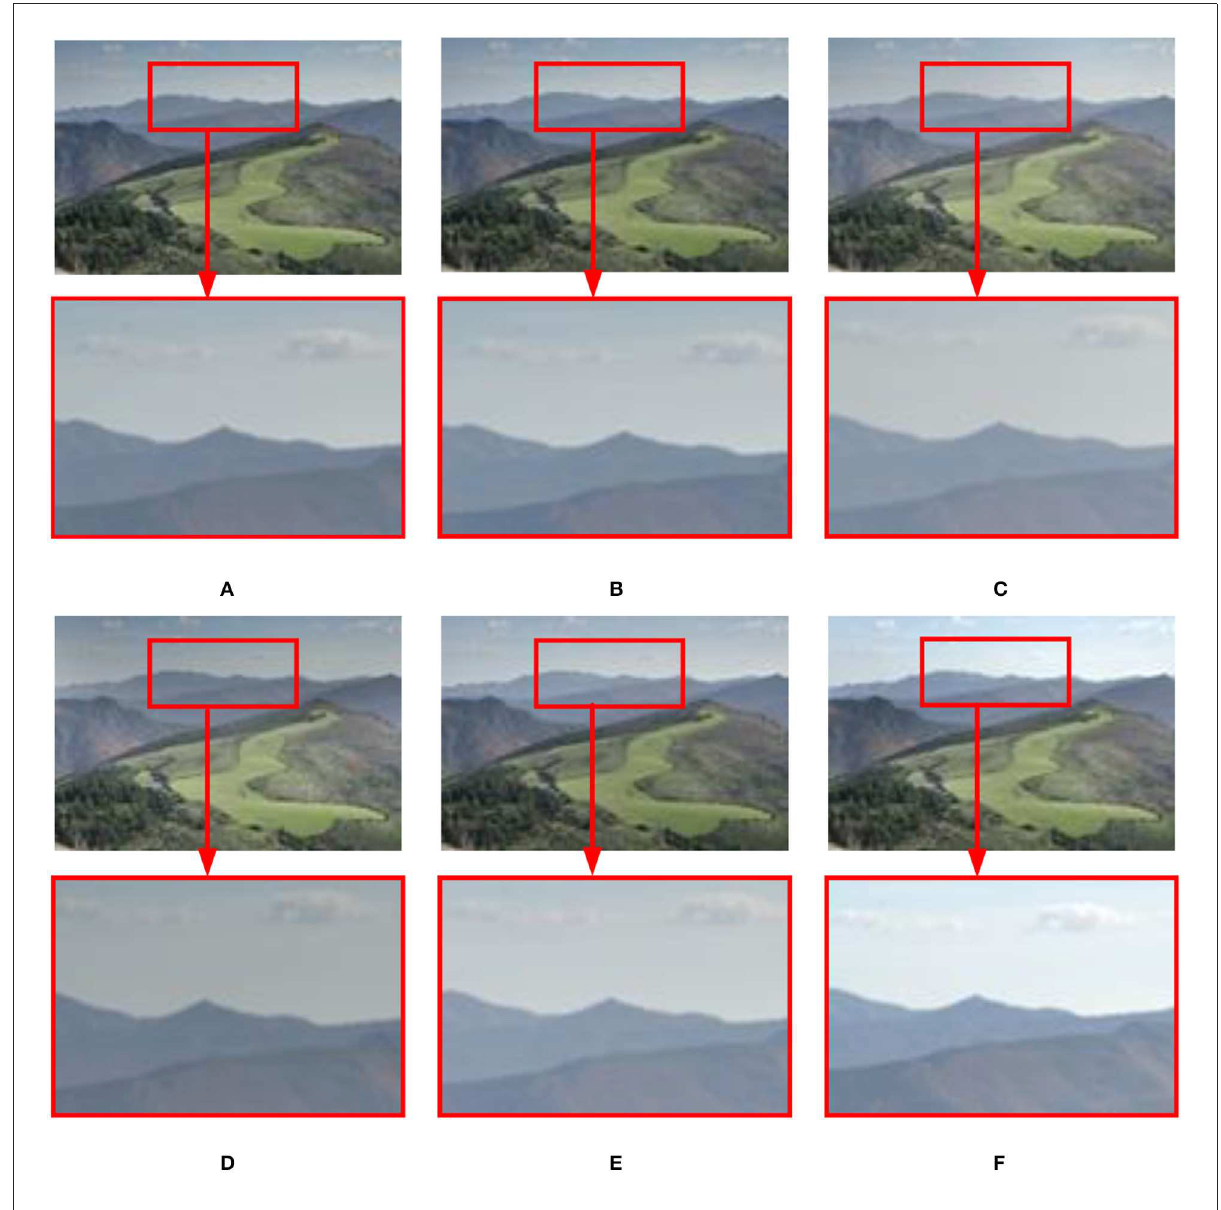
FIGURE11 Comparison results of different methods on the static “Landscape” image sequence. (A) Hayat and Imran (2019); (B) Mertens et al. (2007); (C) Li and Kang (2012); (D) Liu and Wang (2015); (E) Lee et al. (2018); (F) the proposed method in this study.